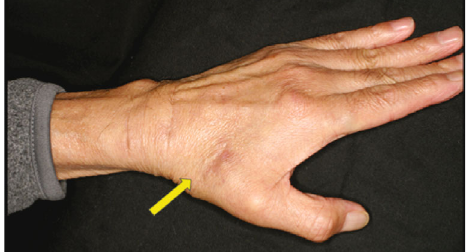
Figure 4: Postoperative macroscopic fi ndings. Improvements in the EPL tendon could not be con fi rmed, and the transferred tendon is not palpable in the snu ff box (arrow).